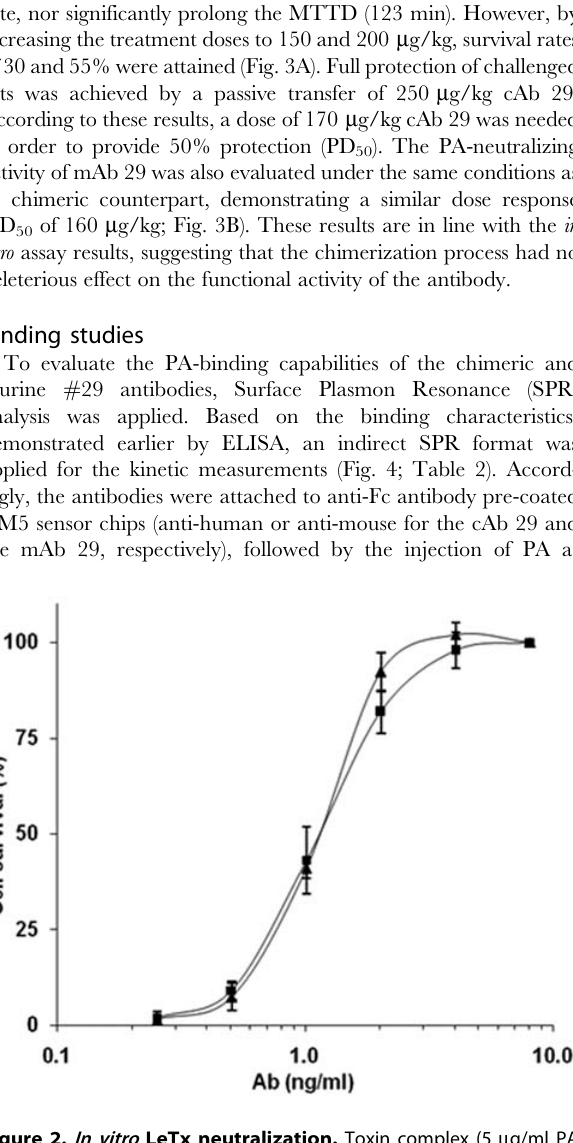
Figure 2. Invitro LeTx neutralization. Toxin complex (5 m g/ml PA and 2 m g/ml LF) was pre-incubated for one hour with increasing concentrations of cAb 29 (triangles) or mAb 29 (squares), and added to J774A.1 mouse macrophage cells for 5 hours. Cell survival was then determined by MTT, and was plotted as percent of untreated control cells. Points are mean 6 STD of triplicate